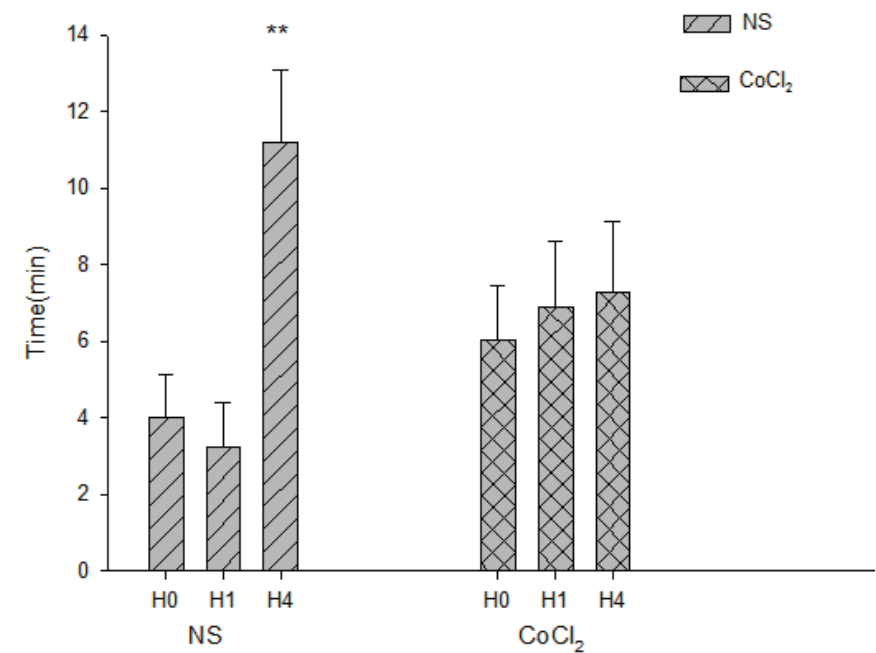
Figure 6. The abolishment time of population spikes (PS) in hippocampal slices of hypoxia-preconditioned mice treated with CoCl H0 and H1 in NS